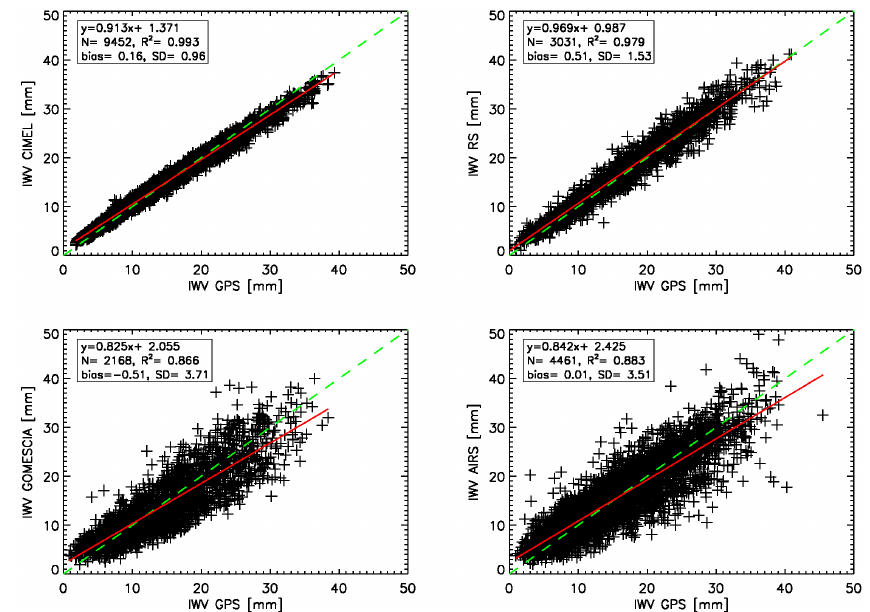
Figure 5. Scatter plot of coincident IWV measurements of the different instruments with the GPS device at Uccle, Brussels, Belgium.